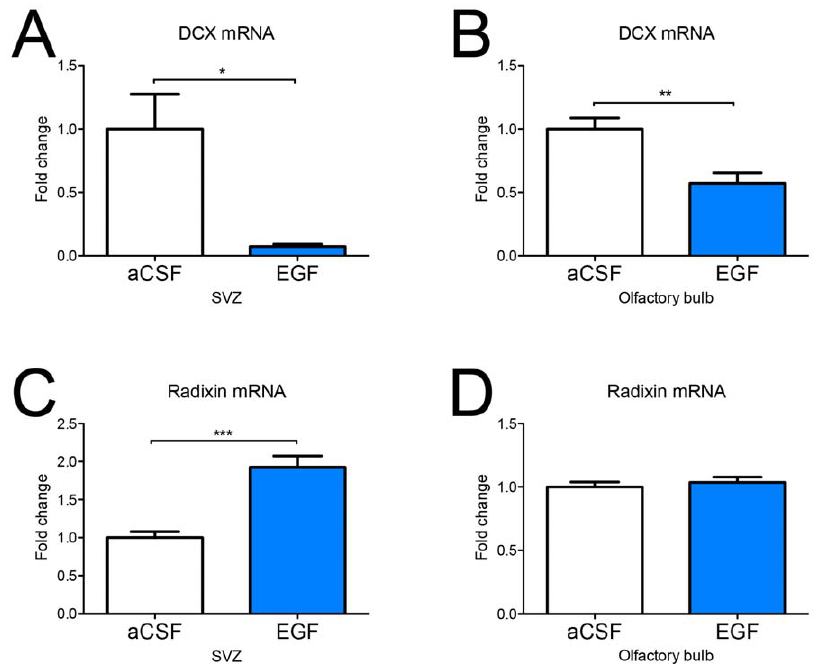
Figure 2. mRNA expression of doublecortin and radixin in the SVZ and olfactory bulb after EGF infusion. mRNA expression of the neuroblast-associated marker doublecortin ( DCX ) and radixin in the subventricular zone (SVZ) and olfactory bulb (OB) after 14 days of EGF infusion were determined by qPCR. Relative mRNA levels of DCX ( A, B ) and radixin ( C, D ) are expressed as fold-change compared to control 6 SEM using the Delta-Delta Ct method. Statistical significance was assumed at * p , 0.05, ** p , 0.01 and *** p , 0.001 using Student’s t-test. n=5 animals for the aCSF and the EGF group.